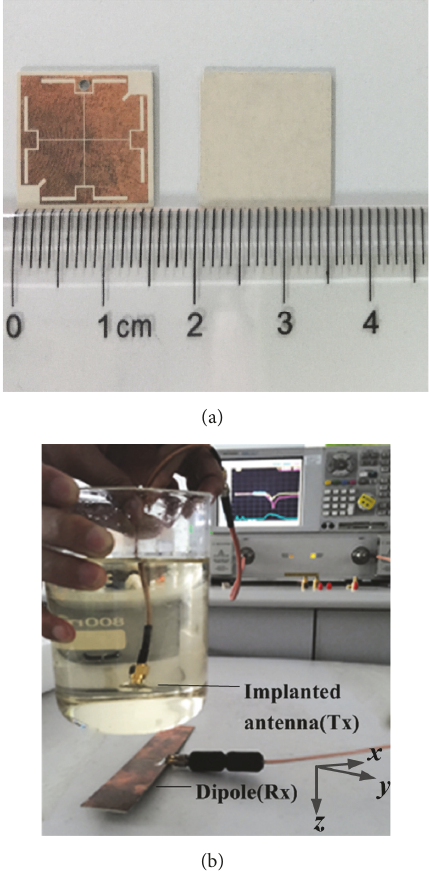
Figure 11: (a) The prototype of the fabricated antenna; (b) illustra- tion of the measurement setup.